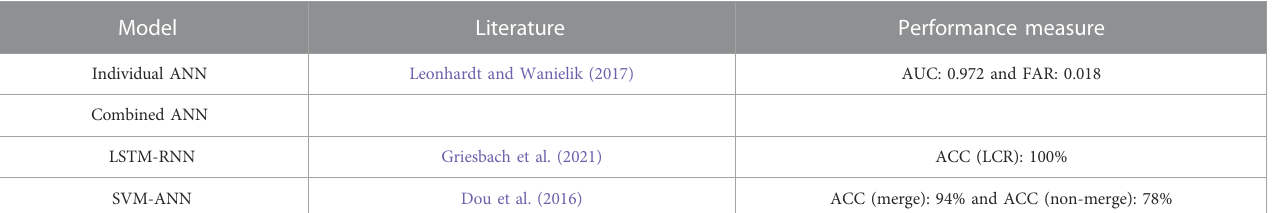
TABLE 4 Summary of ANN-based models for lane-changing